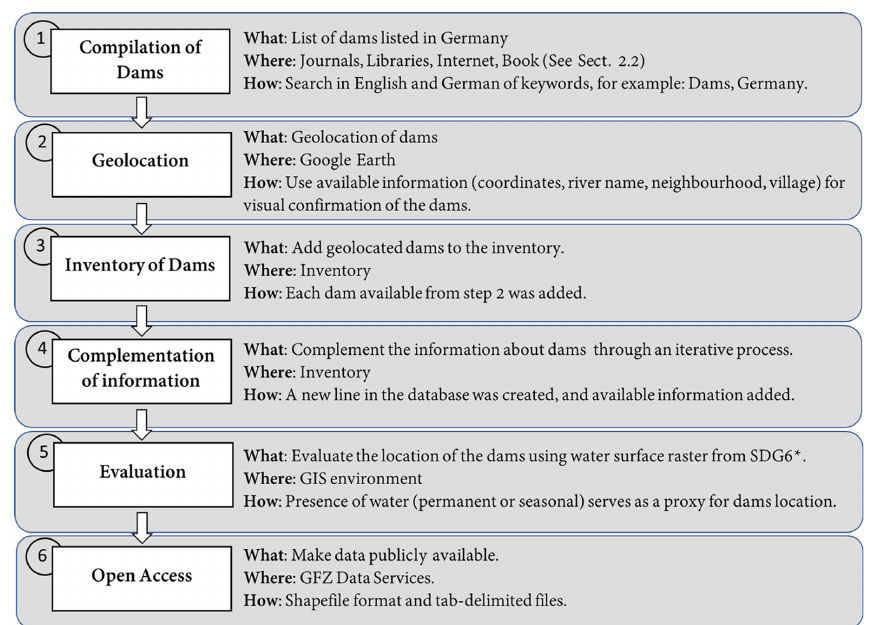
Figure 1. Procedure for the compilation of the dam inventory. * Sustainable Development Goal 6 app (https://www.sdg661.app/ data-products/data-downloads, last access: 25 February